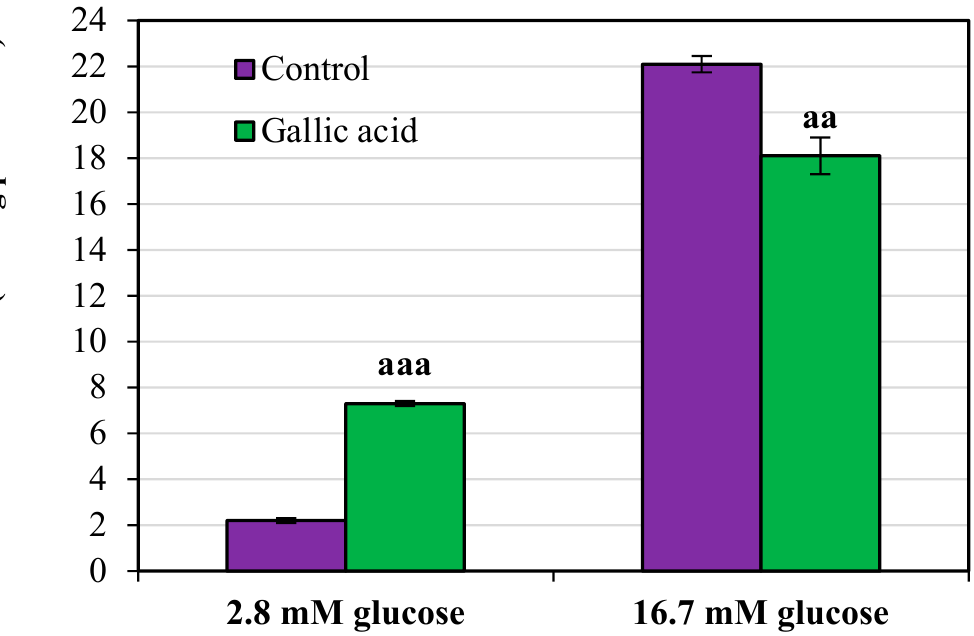
Figure 4. E ff ect of gallic acid on the level of insulin secretion on rat’s pancreatic islets cells after 24